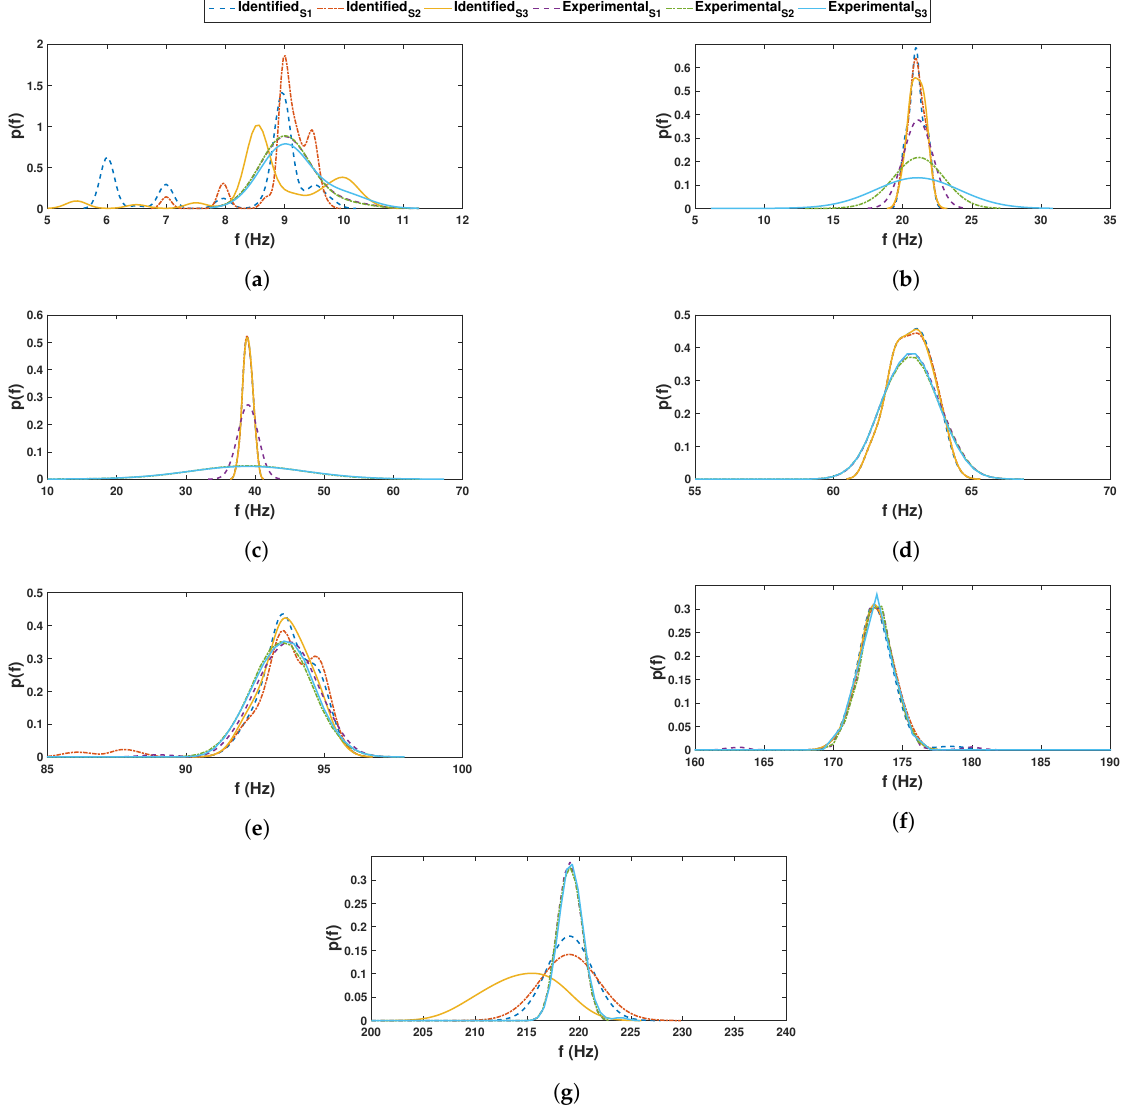
Figure 13. Comparison of pdf of identified and experimental cases for the first 7 frequencies for beam